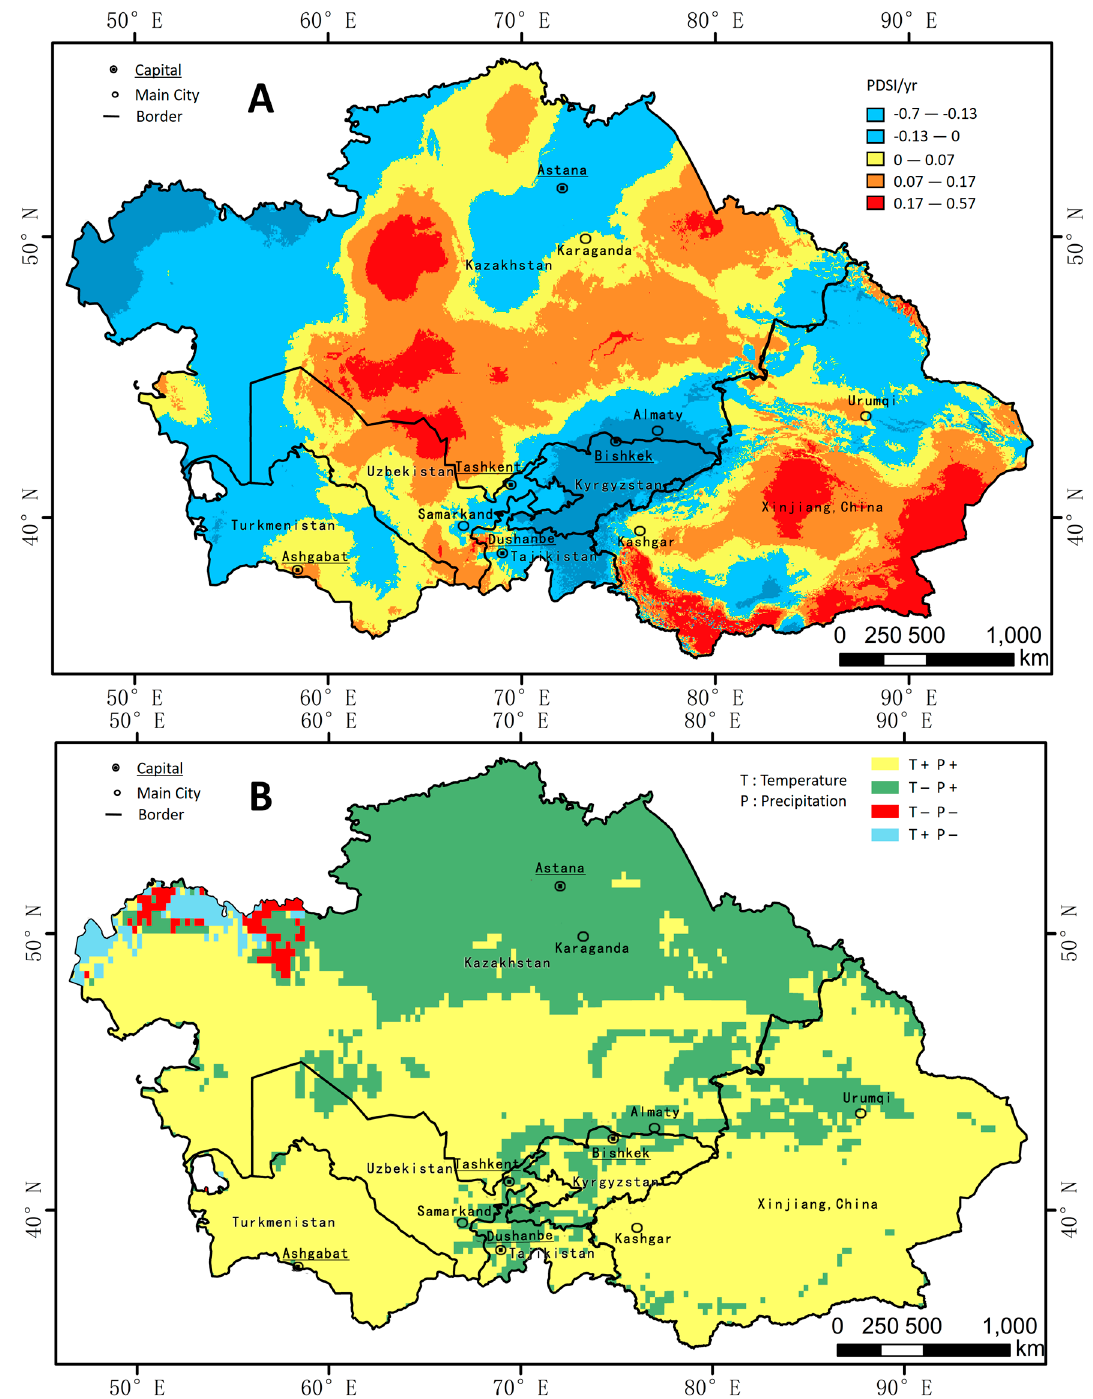
Figure 10. Spatial pattern of climate change in Central Asia from 2001 to 2017. ( A ) Change in the PDSI, PDSI/yr indicates the slope of the change in the annual average PDSI. ( B ) Temperature-precipitation change zoning map. +/ − indicates that the slope of the change in the annual average temperature or annual precipitation is greater or less than 0.